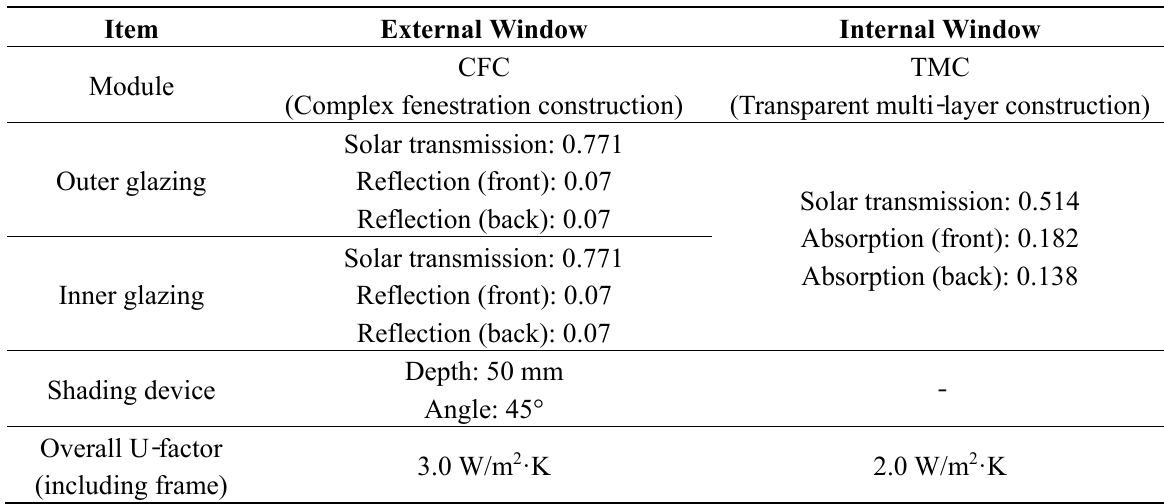
Table 4. Properties of the